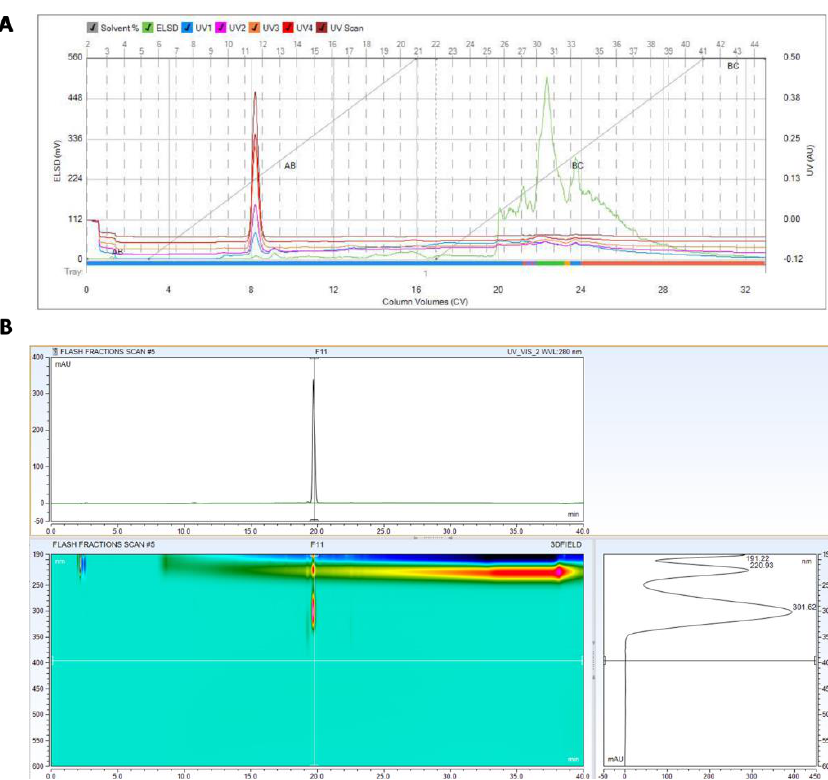
Figure 3. Purification of the Trichoderma asperellum (P1) active ingredient(s) that inhibit M. maydis